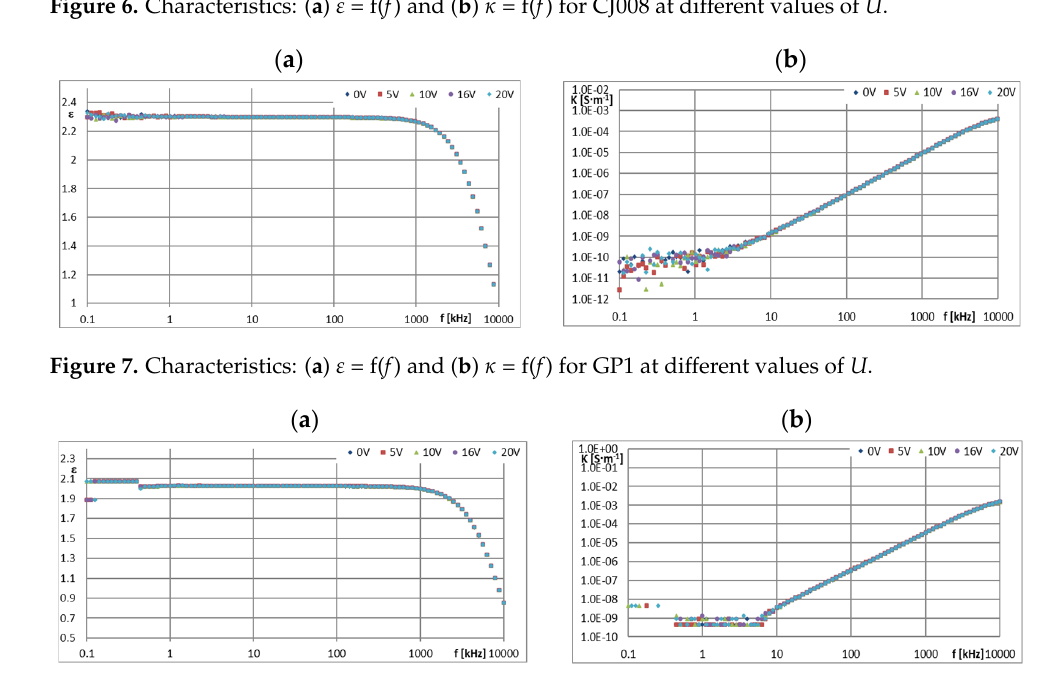
Figure 8. Characteristics: ( a ) ε = f( f ) and ( b ) κ = f( f ) for PAO6 at different values of U.